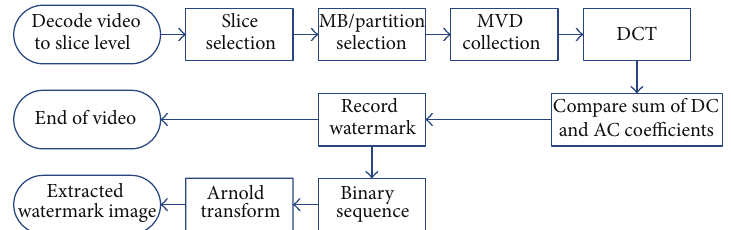
Figure 9: Watermark detection approach.